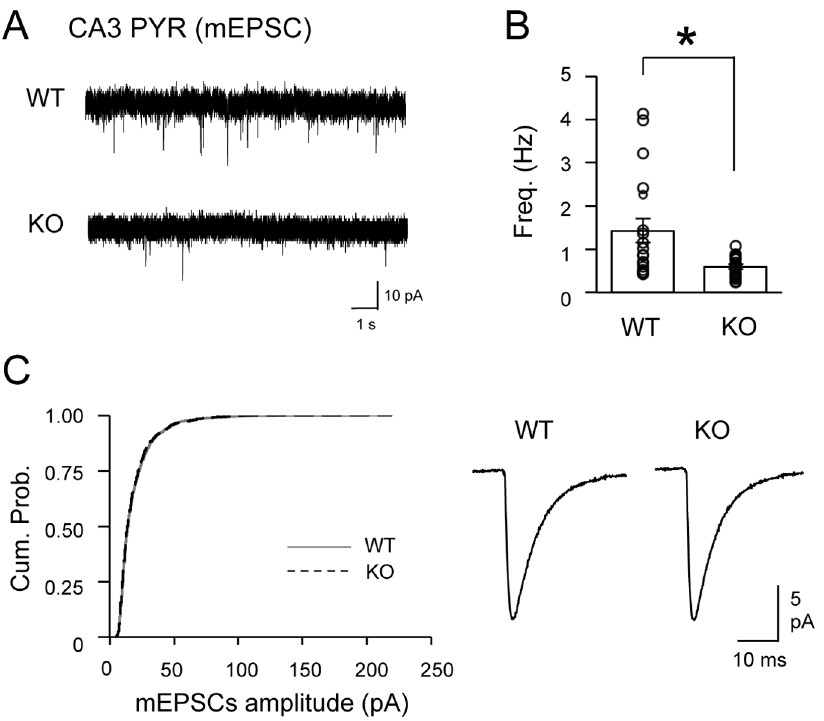
Figure 5. Reduced frequency of mEPSCs in CA3 PYRs of BACE1 KOs. (A) Representative mEPSC traces from CA3 PYRs in WTs and KOs. (B) BACE1 KOs showed significantly decreased mEPSCs frequency in CA3 PYRs compared to WTs. mEPSC frequency of each cell is shown as open circles. *t-test: P , 0.01. (C) Amplitude of mEPSCs in CA3 PYRs was not altered in KOs. Left: The cumulative probability curve of KO mEPSC amplitudes (black dotted line) superimposed with that of WT (gray solid line) (K–S test, P . 0.5). Right: Average mEPSC traces from PYRs of the two groups.